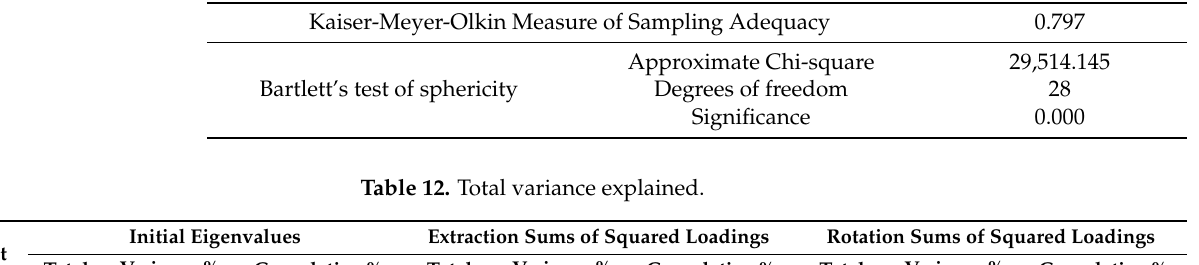
Table 11. KMO and Bartlett sphericity test.